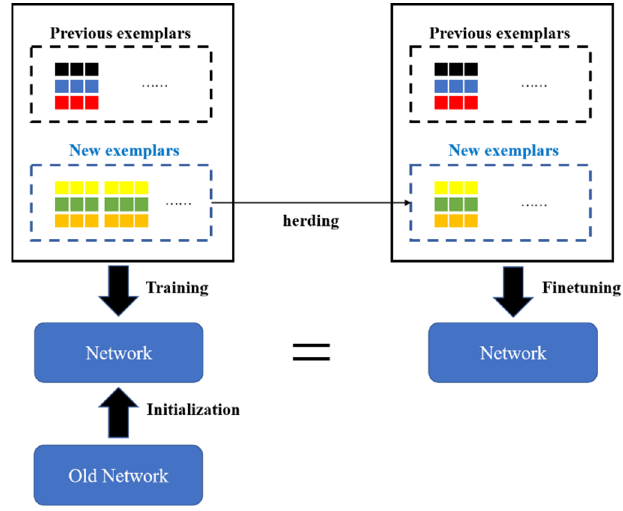
Figure 3. The CIL method used in our experiments. The whole training process consists of ( N + 1) phases, including one initial phase and N incremental phases. The initial phase of training takes a subset of data to train an initial model to recognize a subset of classes, while the following phases incrementally add more samples to fine tune the model to recognize new object classes. To prevent catastrophic forgetting, a fixed-sized exemplar set is kept and updated to include typical training samples for all classes that have been seen. At each incremental phase, samples from the exemplar set are also used for training and will be updated to stay current after the incremental learning completes.